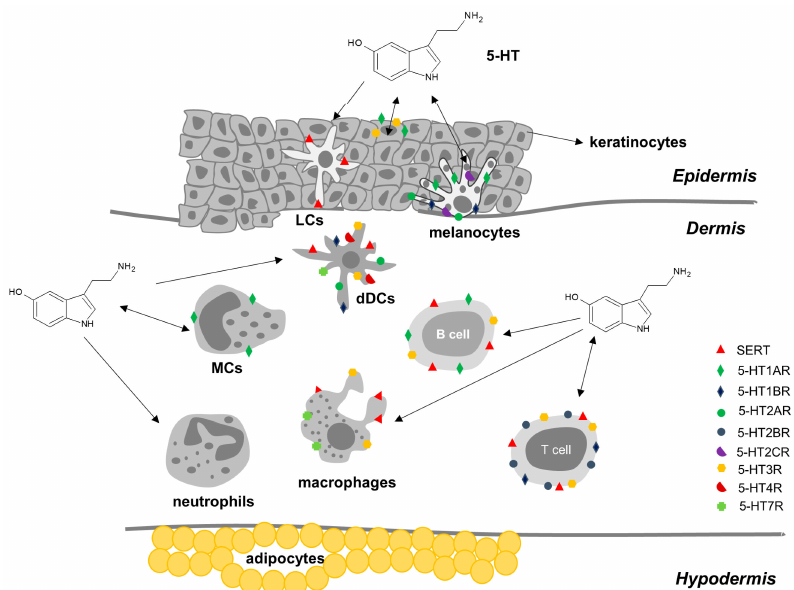
Figure 3. Serotonin, serotonin transporter (SERT) and serotonin receptors (5-HTRs) in human skin immunocytes and non-immunocytes. The cell activation state and environment influence the e ff ects of 5-hydroxytryptamine (5-HT) by changing the receptor and transporter expression. The figure shows all the membrane proteins that may be present at any given time. Double arrows represent the production of 5-HT by the cells and the e ff ect of 5-HT on the same cells; single arrows initiating in cells represent the production of 5-HT by these cells, while arrows initiating in 5-HT represent the direct or indirect e ff ects of 5-HT on these cells. LCs, Langerhans cells; dDCs, dermal dendritic cells; MCs, mast